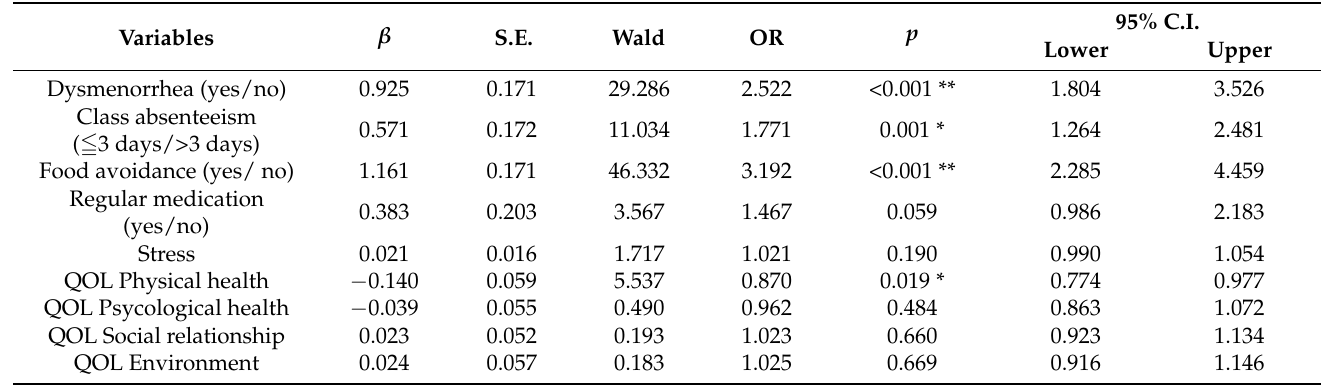
Table 4. Logistic Regression for Risk Factors of IBS (N =